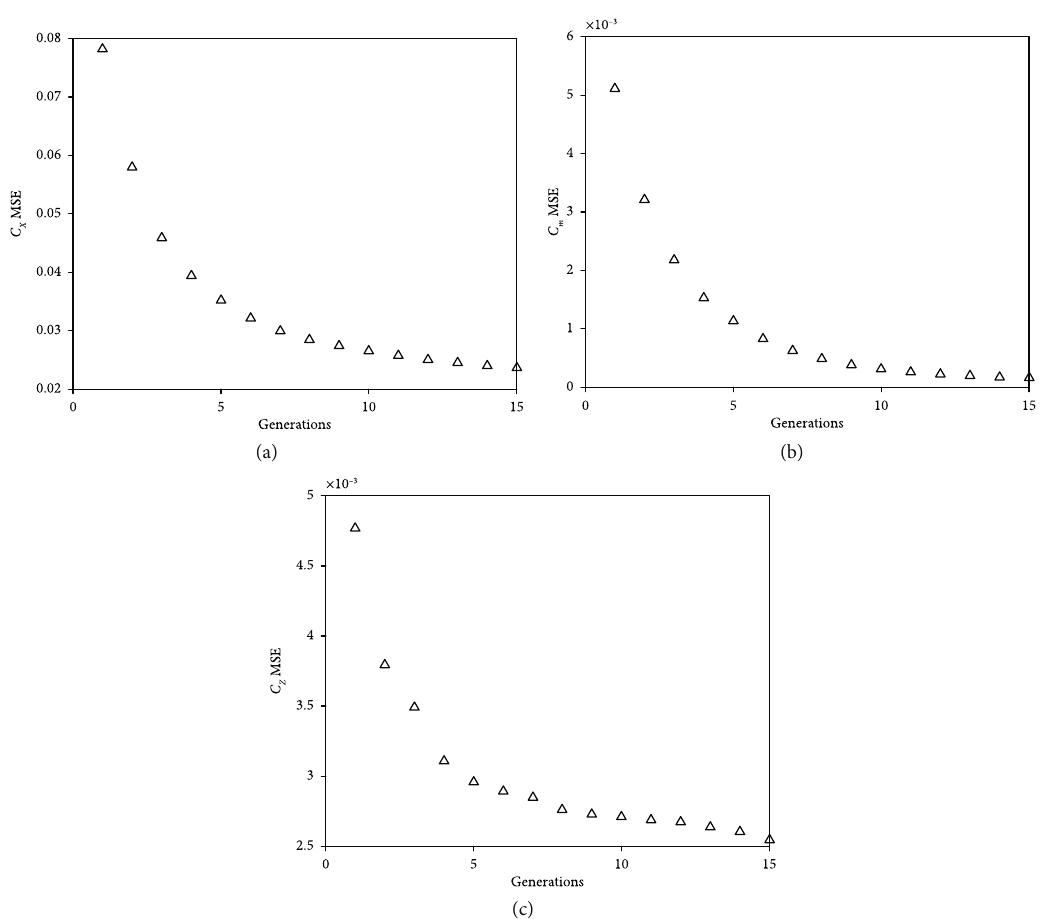
Figure 11: Mean square error of NSGA-II generation by generation: (a) C